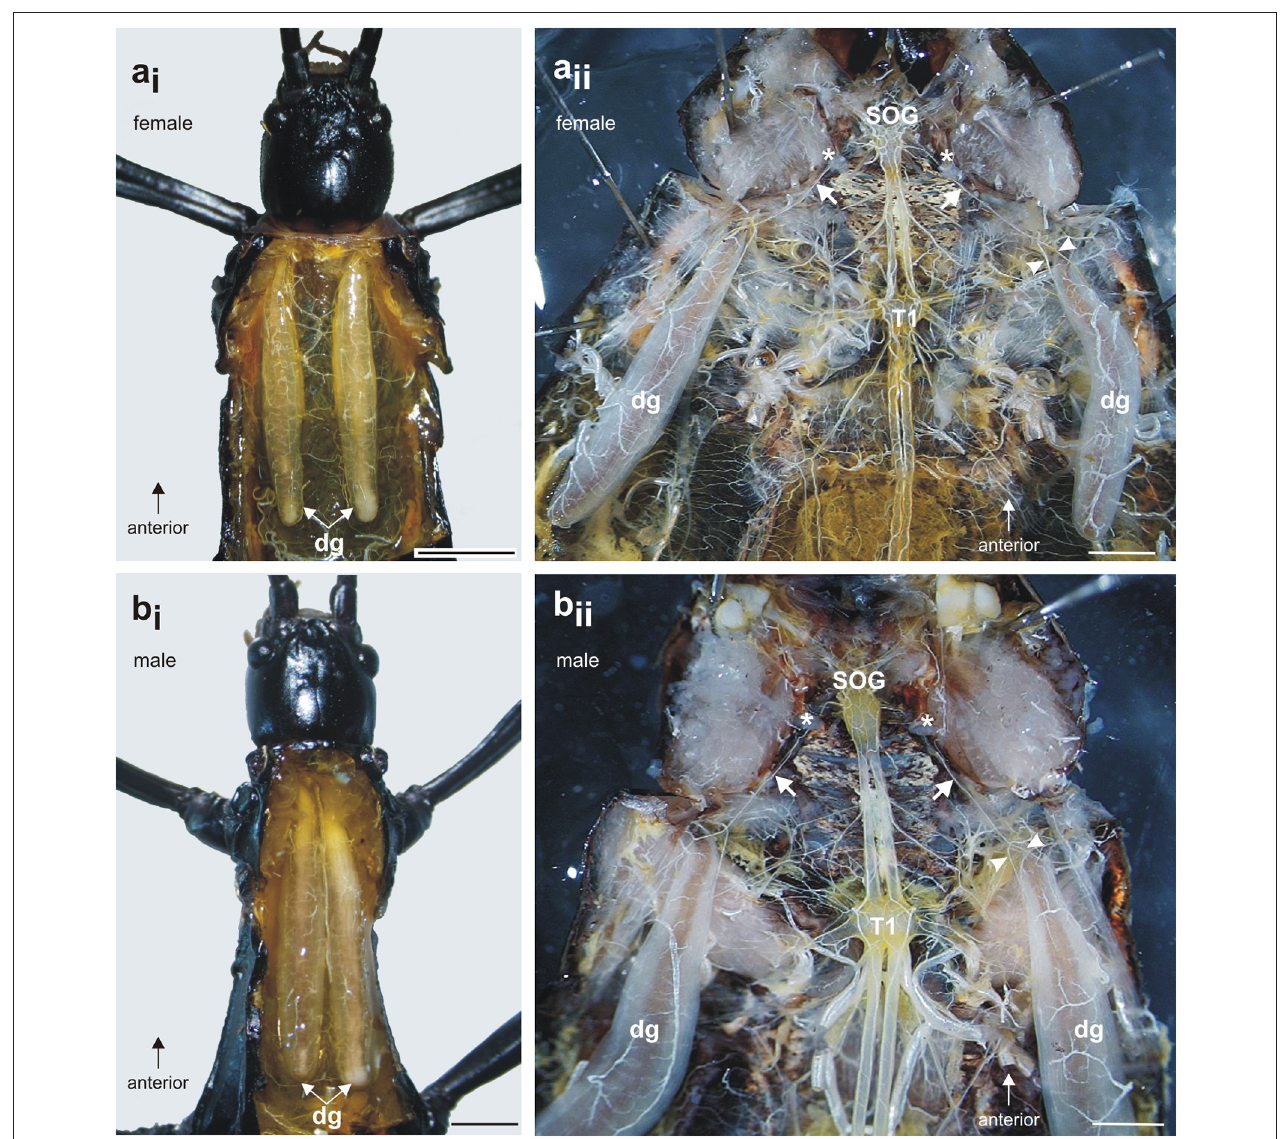
FIGURE 2 | Defense glands in A. paromalus (a) female and (b) male individuals. (a i , b i ) Paired defense glands lay dorsally in the prothorax. (a ii , b ii ) The innervation by a prominent nerve from the subesophageal ganglion (SOG) is similar in both sexes: the nerve (white arrow) runs under a cuticular apodeme (asterisk) toward the anterior defense gland where it splits into two nerve branches which contact the gland surface (white arrowheads). Scales: female = 4mm, male = 2mm. dg, defense glands; T1, prothoracic ganglion; SOG, subesophageal